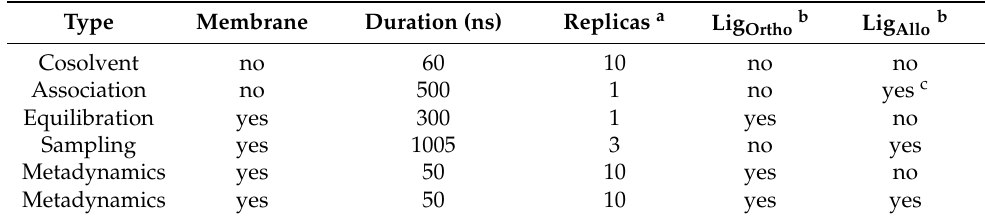
Table 1. Simulations conducted in this